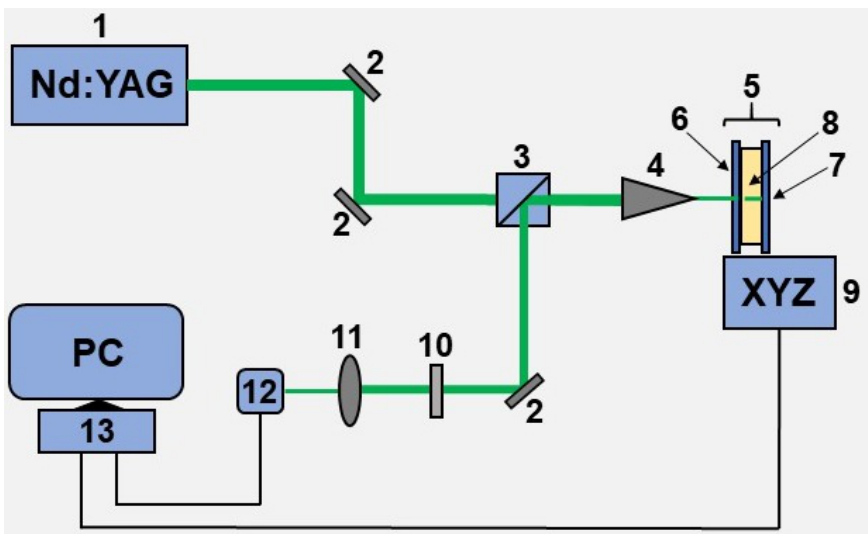
Figure 1. The schematic picture of the experimental setup used for the fabrication of Cu-based electrodes. 1—Nd:YAG 532 nm blue cw (continuous-wave) laser, 2—Al mirror, 3—splitting cube, 4—microscope objective, 5—experimental chemical cell, 6—glass window, 7—electrode glass substrate, 8—chemical solution (see Table 1), 9—XYZ motorized stage, 10—attenuation fil- ter, 11—focusing lens, 12—web-camera, 13—personal computer.